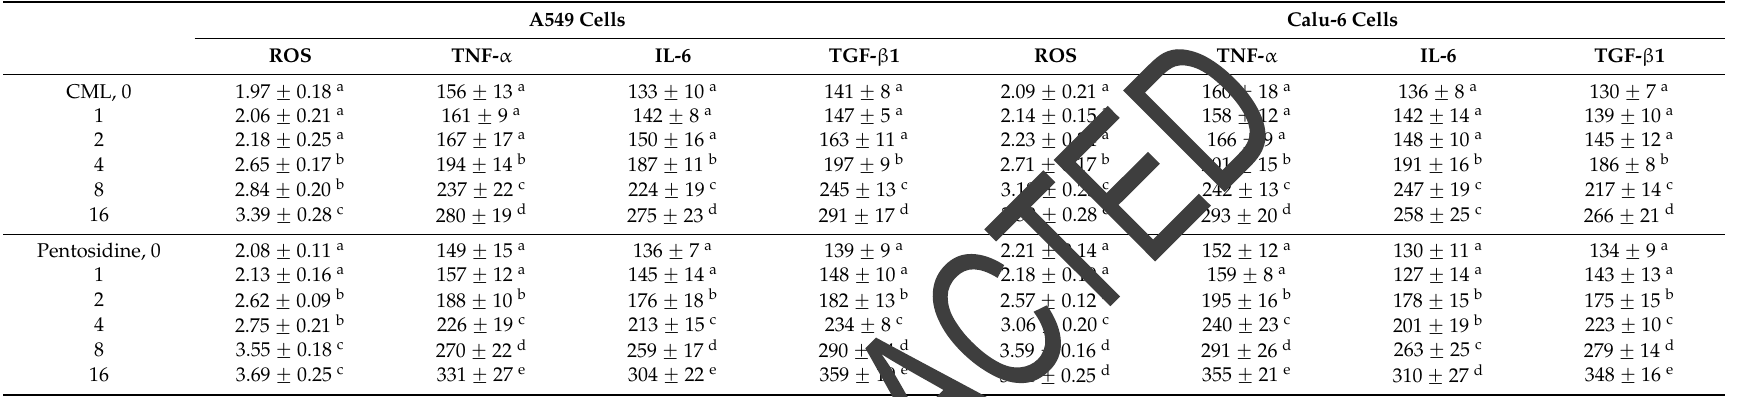
Table 3. Effects of CML or pentosidine at 0 (control), 1, 2, 4, 8 or 16 µ mol/L upon ROS (RFU/mg protein), TNF- α (pg/mg protein), IL-6 (pg/mg protein) and TGF- β 1 (pg/mg protein) levels in human A549 and Calu-6 cells. Cells were exposed to CML or pentosidine for 18 h at 37 ˝ C. Data are mean ˘ SD ( n = 10). a–e Means within a column without a common letter differ, p <